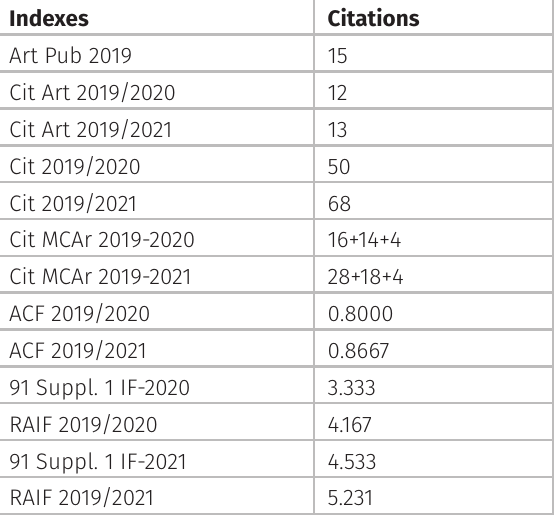
Table I. Citations and indexes concerning the articles published in the issue 91 Suppl. 1 by the Annals of the Brazilian Academy of Sciences that have been considered in the Impact Factor of 2020 and